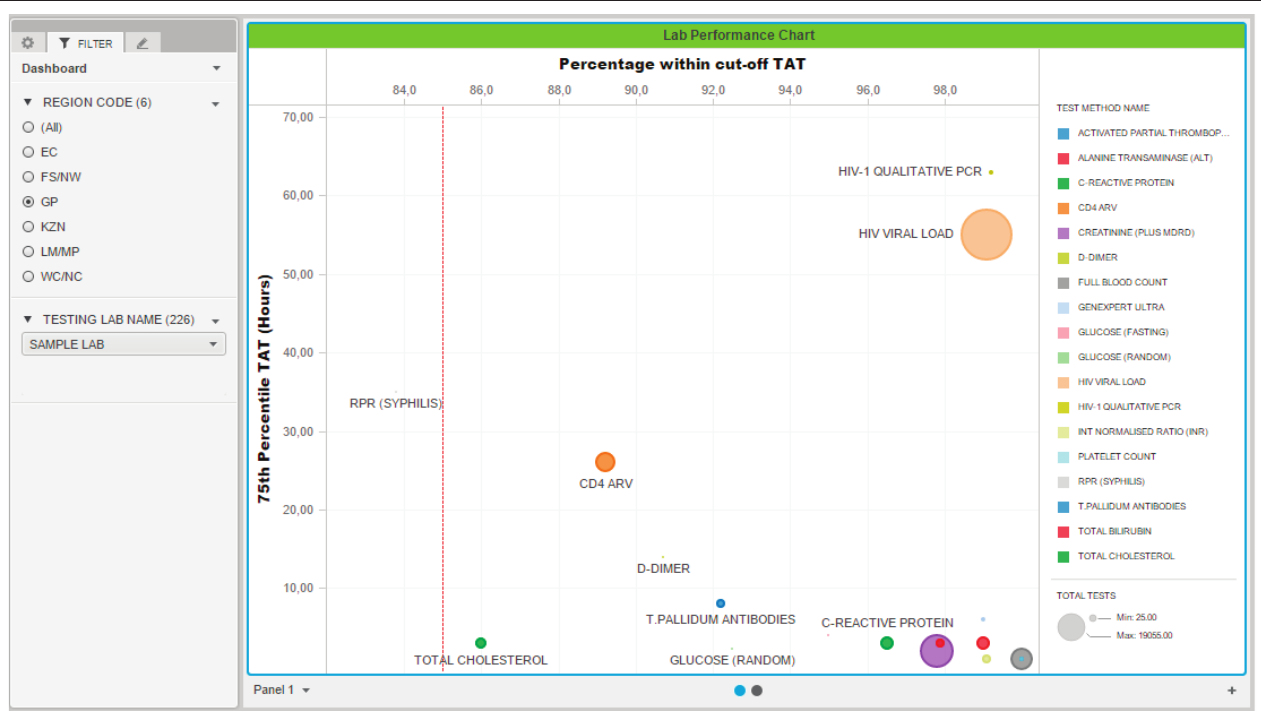
FIGURE 3: An example of the Microstrategy Desktop bubble dashboard chart used to report total turn-around time data for an example site’s week’s data, South Africa, 2018. The percentage within cut-off turn-around time is reported on the x -axis with the 75th percentile turn-around time on the y -axis. The bubble size indicates test volumes. Reference lines were added at 85 % within stipulated turn-around time cut-off on the x -axis. Each test within the test basket is colour coded with the key provided on the right. Outlying tests are immediately